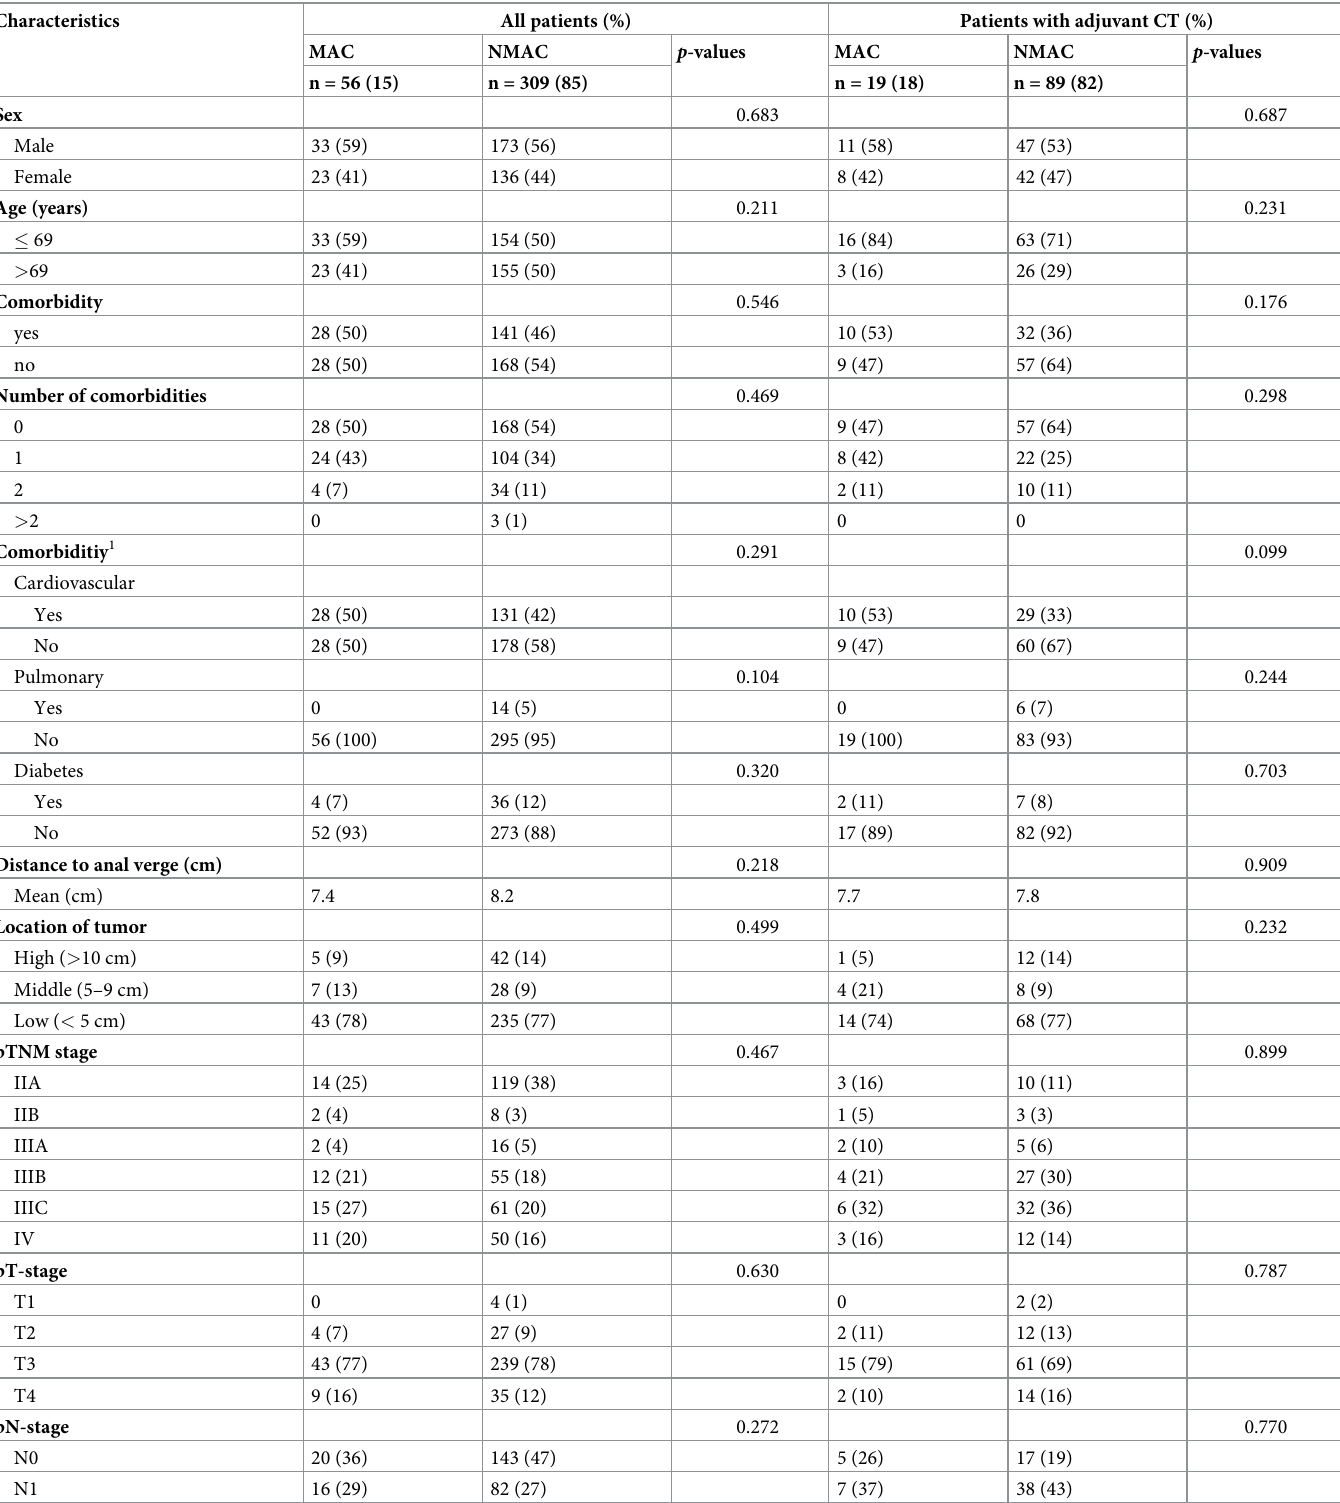
Table 1. Clinicopathological characteristics of rectal cancer